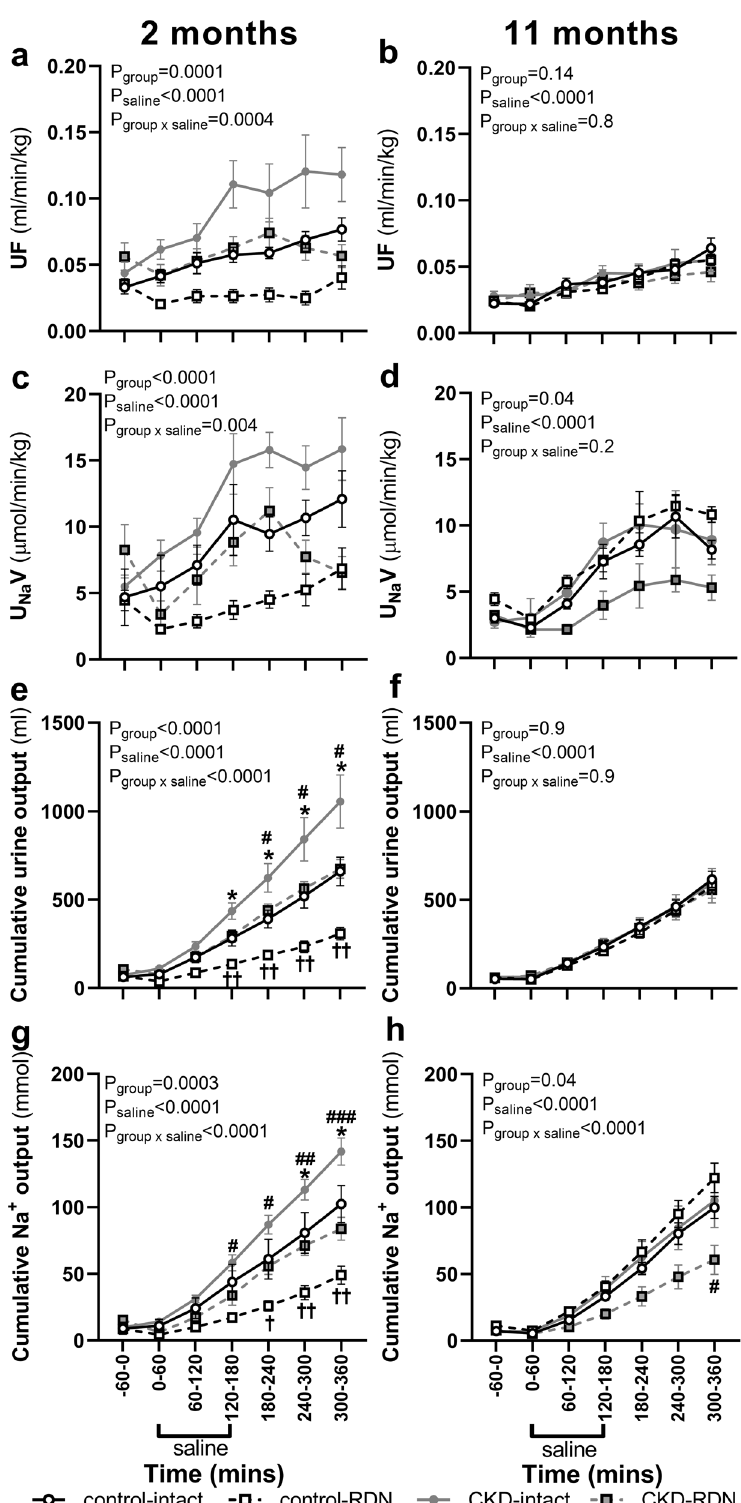
Figure 3. Urine flow, urinary sodium excretion, cumulative urine and sodium output in response to isotonic saline loading. Responses examined in normotensive sheep and sheep with hypertensive chronic kidney disease (CKD) at 2 and 11 months after sham (intact) or renal denervation (RDN) procedure. Data are at baseline; − 60–0 min, during 180 min of saline infusion and during 180 min of recovery post saline infusion. Data are mean ± SE. *P < 0.05 comparing CKD-intact with control-intact, # P < 0.05, ## P < 0.01, ### P < 0.001 comparing CKD-intact with CKD-RDN, † P < 0.05, †† P < 0.01comparing control-intact with control-RDN, from post-hoc analysis following repeated measures ANOVA. UF urine flow, U Na V urinary sodium